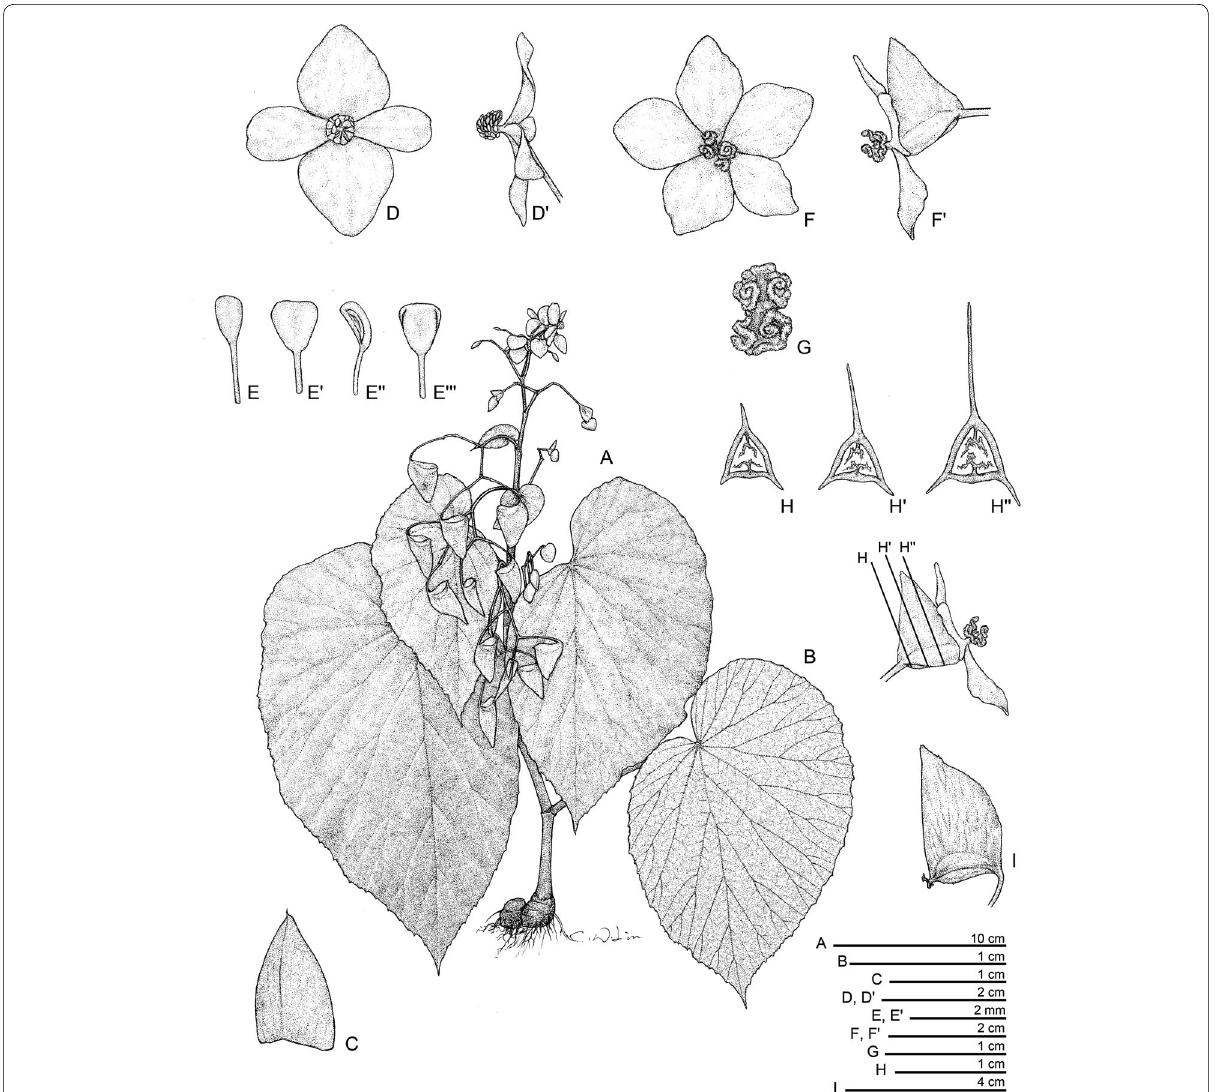
Fig. 1 Begonia myanmarica C.‑I Peng & Y. D. Kim. A Habit. B Leaf adaxial surface. C Stipule. D Male flower, face view, D ′ Male flower, side view. E, E ′ , E ″ , E ‴ Stamen. F Female flower, face view, F ′ Female flower, side view. G Style and stigma. H, H ′ , H ″ , H ‴ Cross section of ovary. I